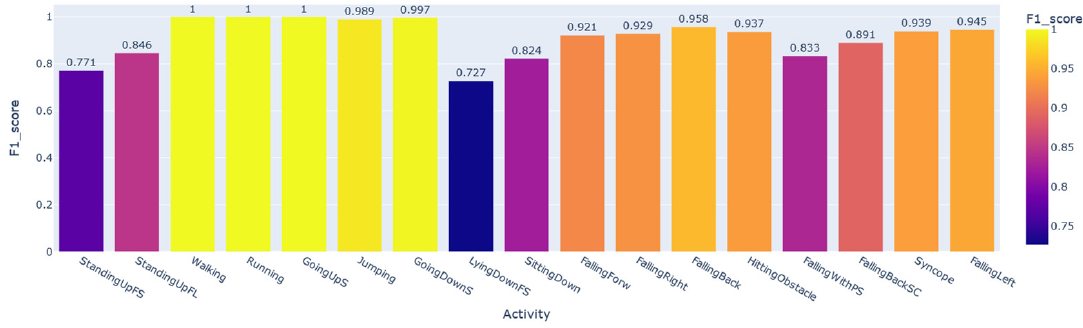
Figure 8. General BUI performance for each activity considering the macro F1-score.